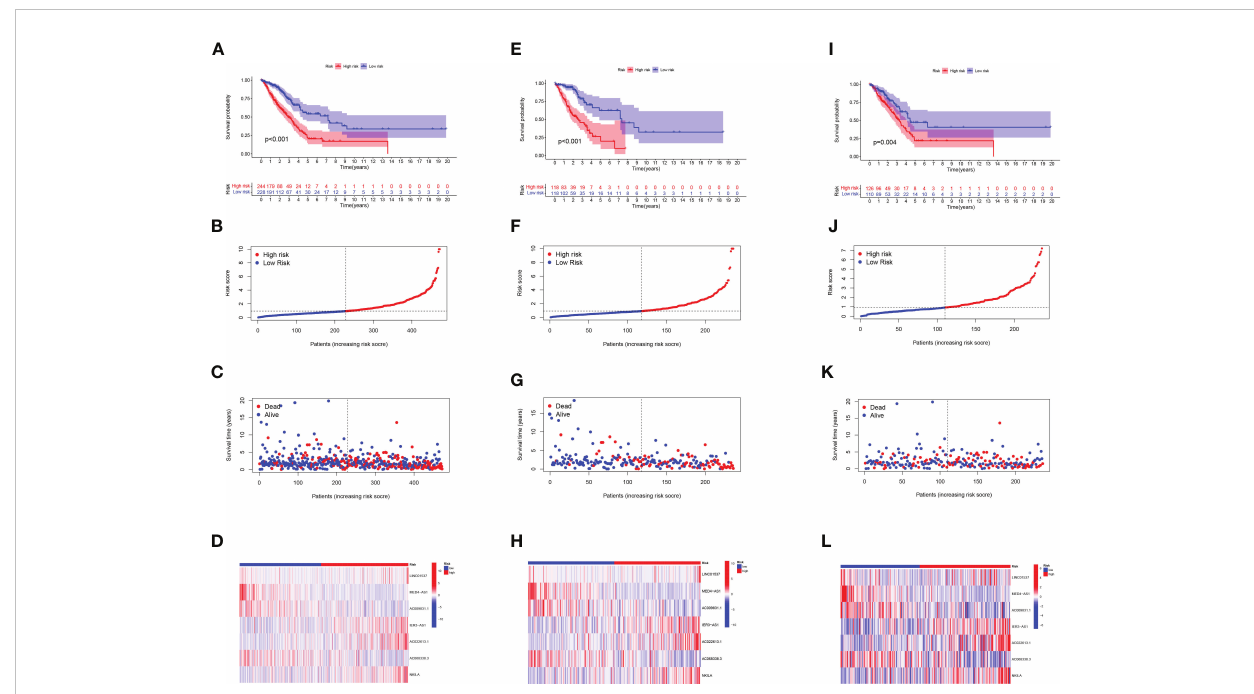
FIGURE 2 Evaluation of the label model of HARlncRNAs in the overall, training, and validation LUAD cohorts. (A, E, I) OS analysis of two subgroups in (A) total set, (E) trial set, and (I) validation set. (B, F, J) Risk score in (B) total set, (F) trial set, and (J) validation set. (C, G, K) Individual survival status in (C) total set, (G) trial set, and (K) validation set. (D, H, L) Heatmap of 7 lncRNAs expression in two subgroups in (D) total set, (H) trial set, and (L) validation